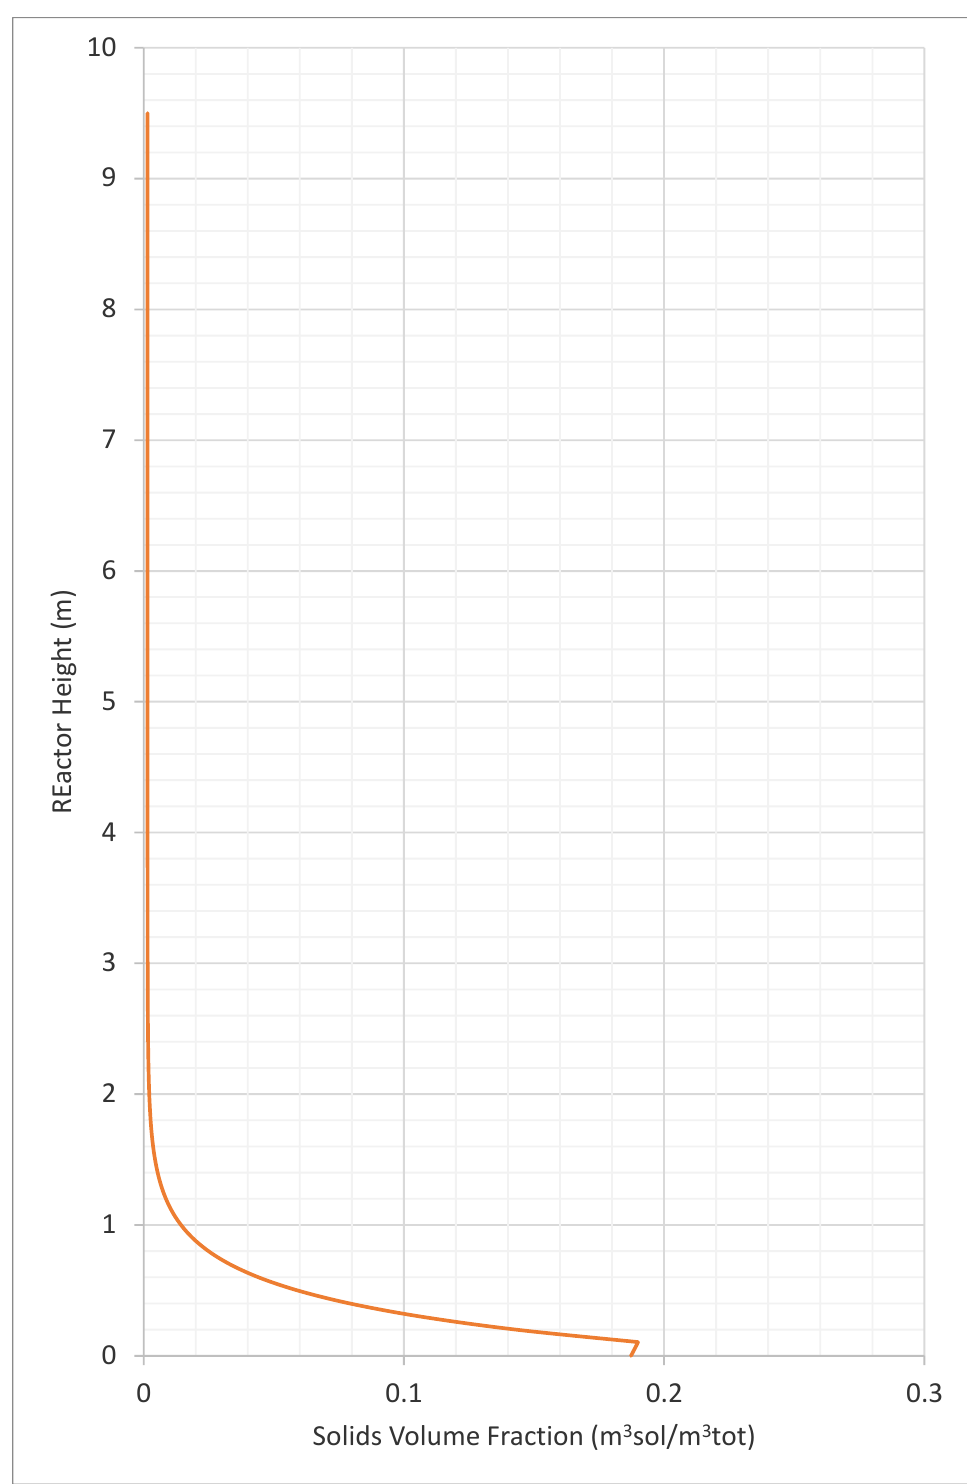
Figure 6. Solids volume fraction in the air reactor [64].